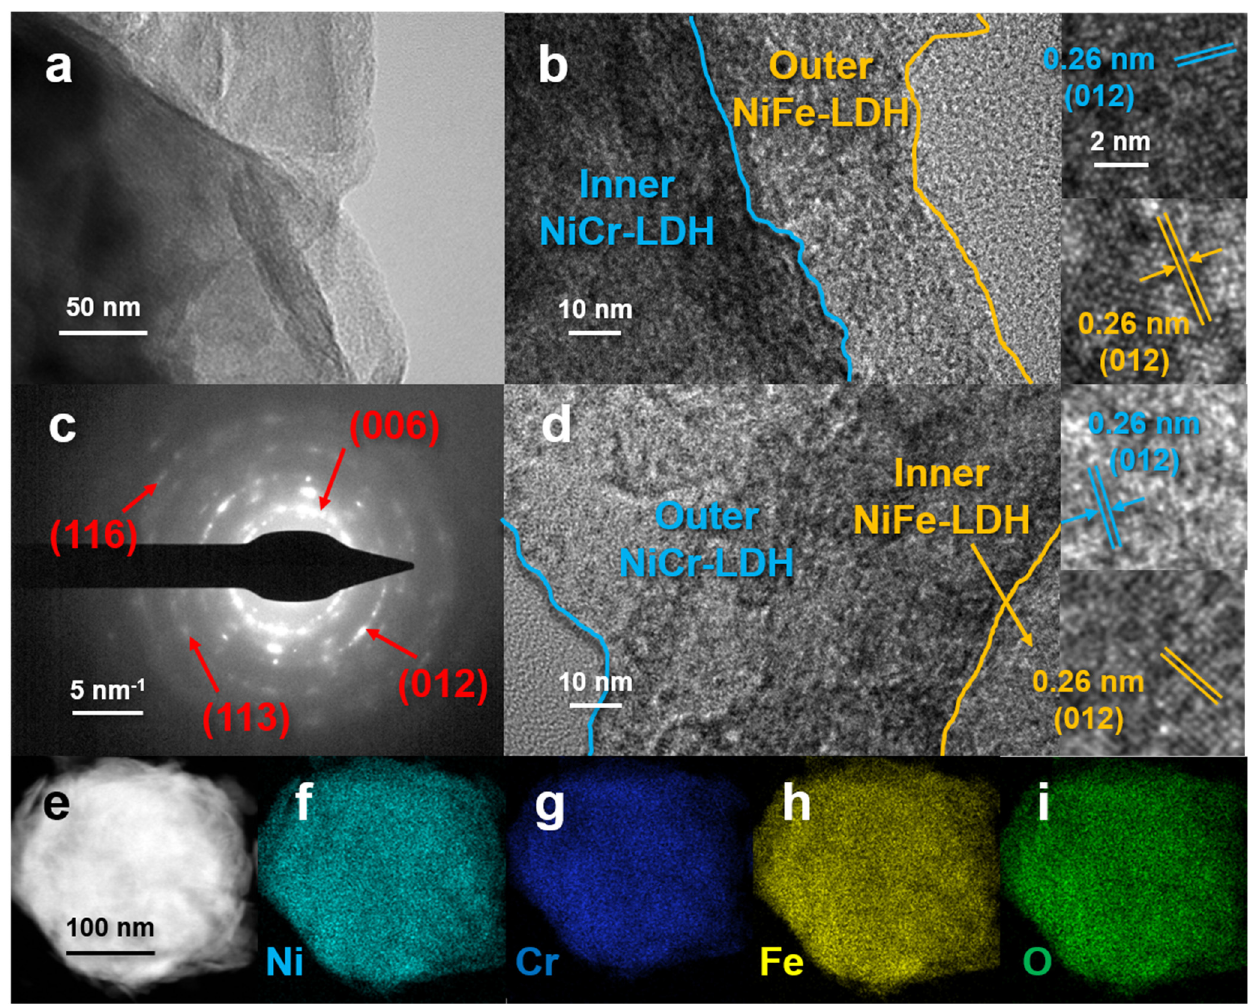
Figure 2. ( a ) Typical TEM image, ( b ) HR-TEM images along with la tt ice fringes of NiCr-LDH and NiFe-LDH phases in NiFe@NiCr-LDH, ( c ) SAED pattern of NiFe@NiCr-LDH nanosheets, ( d ) Typical HR-TEM images of NiCr@NiFe-LDH nanosheets along with la tt ice fringes of NiCr-LDH and NiFe-LDH phases, ( e ) HAADF-STEM image of an NiFe@NiCr-LDH nanosphere, ( f – i ) Elemental mapping of Ni, Cr, Fe, and O elements of the NiFe@NiCr-LDH nanosphere.